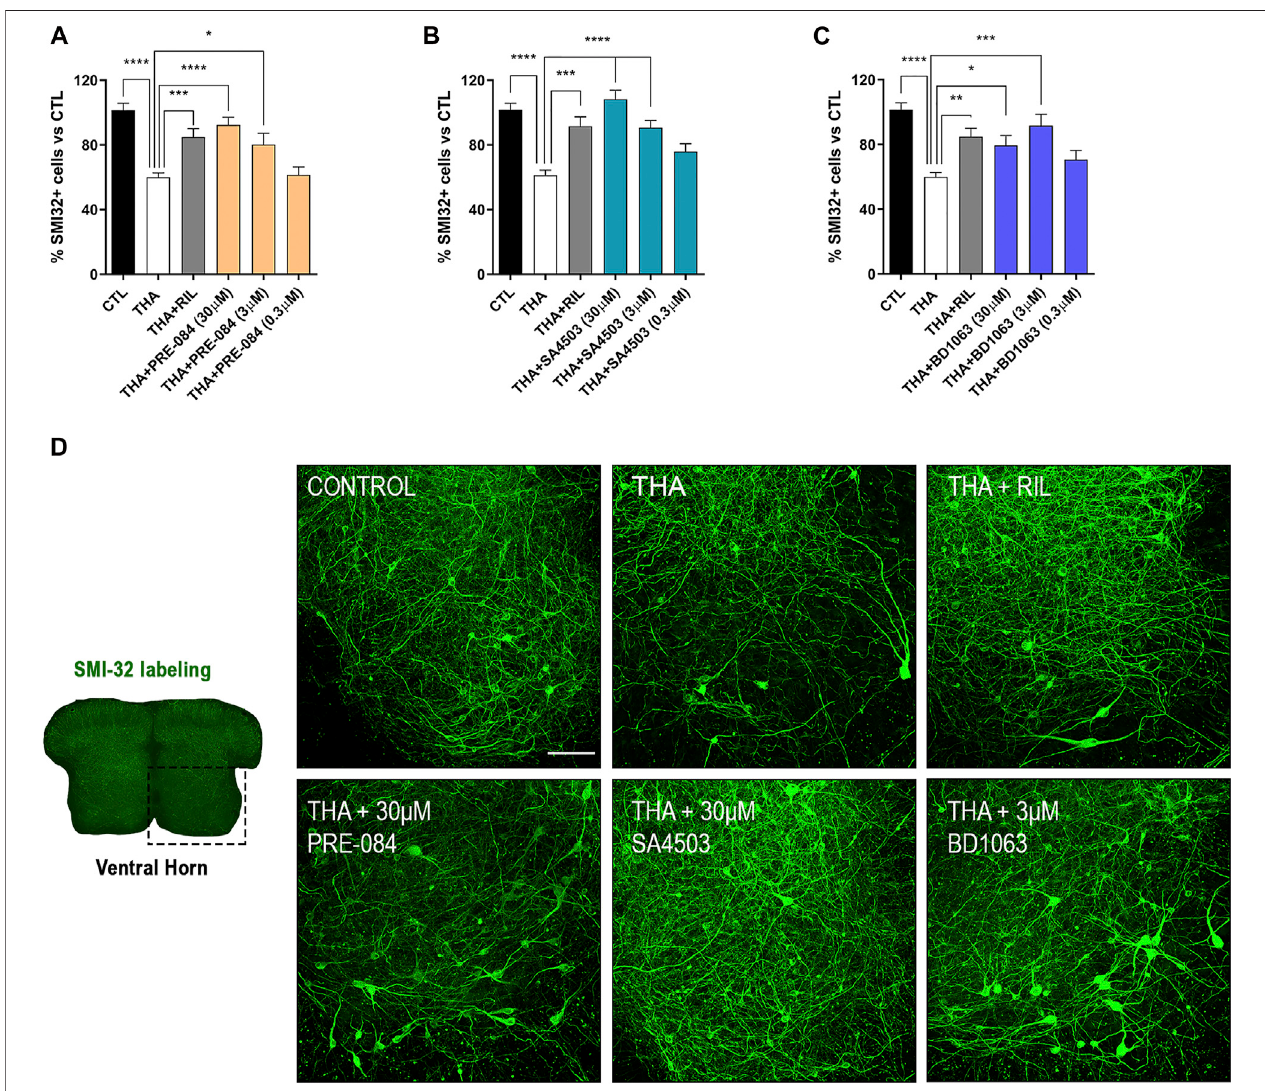
FIGURE 1 | PRE-084, BD1063 and SA4503 prevent MN death under chronic excitotoxicity in vitro (A-C) Plots showing the percentage of SMI-32 positive cells in theventralhornofspinalcord hemislicesunderexcitotoxicity byTHAand theaddition ofSig-1R ligands(mean ± SEM;n (cid:1) 16 – 24hemisectionsper treatment). One-way ANOVAfollowedwithBonferroni ’ sposthoctest:**** p < 0.0001,*** p < 0.001;** p < 0.01,* p < 0.05vsTHAalonecondition (D) MicrophotographofaSCOCslicelabeled with SMI-32 antibody, and representative images of the ventral horn at 28 DIV of all tested conditions. Scale bar 100 μ m.